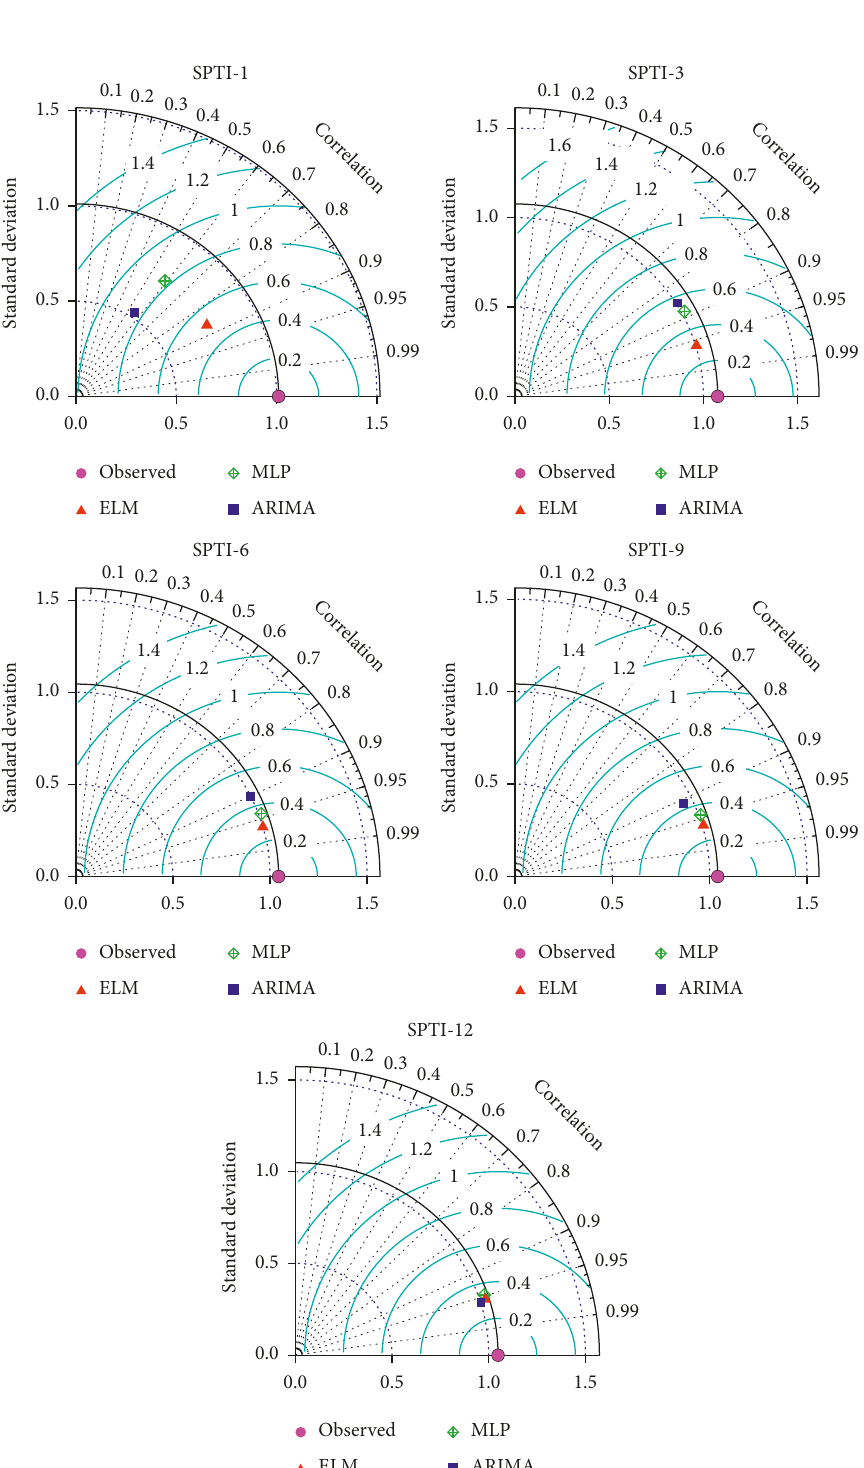
Figure 11: Taylor diagrams for the evaluation of the prediction performance of ELM, MLP, and ARIMA algorithms at Astore station with different time scales in the training